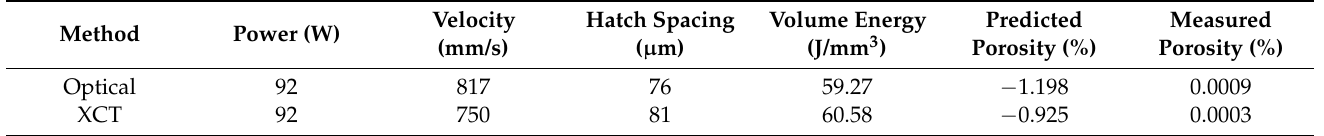
Table 4. Predicted parameter sets that result in minimum porosity.